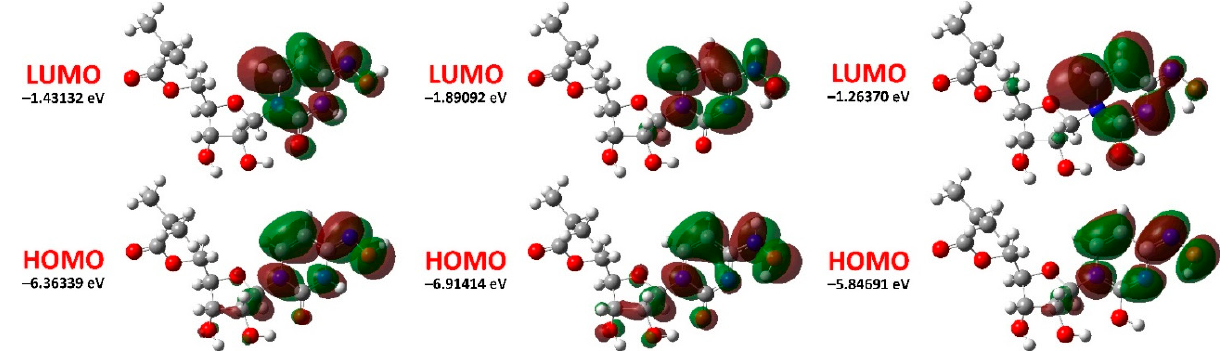
Figure 5. Energy levels and views on the electronic isosurfaces of the HOMO and LUMO of the optimized structures of the keto-oxime ( left ), keto-hydroxylamine ( middle ), and hydroxyl-oxime ( right ) tautomers of molnupiravir, obtained by using the B3LYP/6-311++G(d,p) method. The calculated UV-vis spectra of all tautomers exhibit bands exclusively in the UV region. Particularly, the spectrum of the keto-oxime tautomer contains bands at 168, 175, 230, and 280 nm (Figure 6), which mainly correspond to the transitions at 164.8, 178.3, 180.6, 186.4, 231.0, and 281.3 nm, respectively (Table 6). The latter two low-energy transi- tions are due to HOMO → LUMO and HOMO → LUMO+2 (Table 6). The spectrum of the keto-hydroxylamine tautomers exhibits bands centered at 168 (transitions at 159.1, 169.3, and 170.7 nm), 198 (transitions at 190.6, 199.6, and 201.1 nm), and 267 (transition at 267.0 nm) nm accompanied with a shoulder at about 235 (transitions at 231.0 and 238.0 nm) nm (Figure 6). The latter two low-energy transitions are mainly due to HOMO → LUMO, HOMO → LUMO+1 and HOMO → LUMO+2 (Table 6). The calculated absorption spec- trum of the hydroxyl-oxime tautomer exhibits only two clearly distinguished bands at 169 (transitions at 158.7, 171.3, 173.4, 182.4, and 182.6 nm) and 248 (transitions at 234.6, 248.0, 249.6, and 275.5 nm) nm (Figure 6). The low-energy band is assigned to HOMO → LUMO+1÷7 (Table 6). Figure 6. The calculated UV-vis spectra of the keto-oxime (left), keto-hydroxylamine (middle), and hydroxyl-oxime (right) tautomers of molnupiravir, obtained by using the TD-DFT/B3LYP/6- 311++G(d,p) method. The ionization potential ( I ) and the electron affinity ( A ) value of the molecule, deter- mined as I = − E HOMO and A = − E LUMO (Table 5) [25], are large indicating that the reported tautomers exhibit low electron donating and high electron accepting properties. Notably, the highest and lowest values of I and A were found for the keto-hydroxylamine and hy- droxyl-oxime tautomers, respectively (Table 5). We have further established values of the so-called global chemical reactivity de- scriptors. Chemical potential ( μ ) for the discussed tautomers varies from − 4.40253 to − 3.55531 eV, indicating electron accepting ability and the low donating ability, which is 150